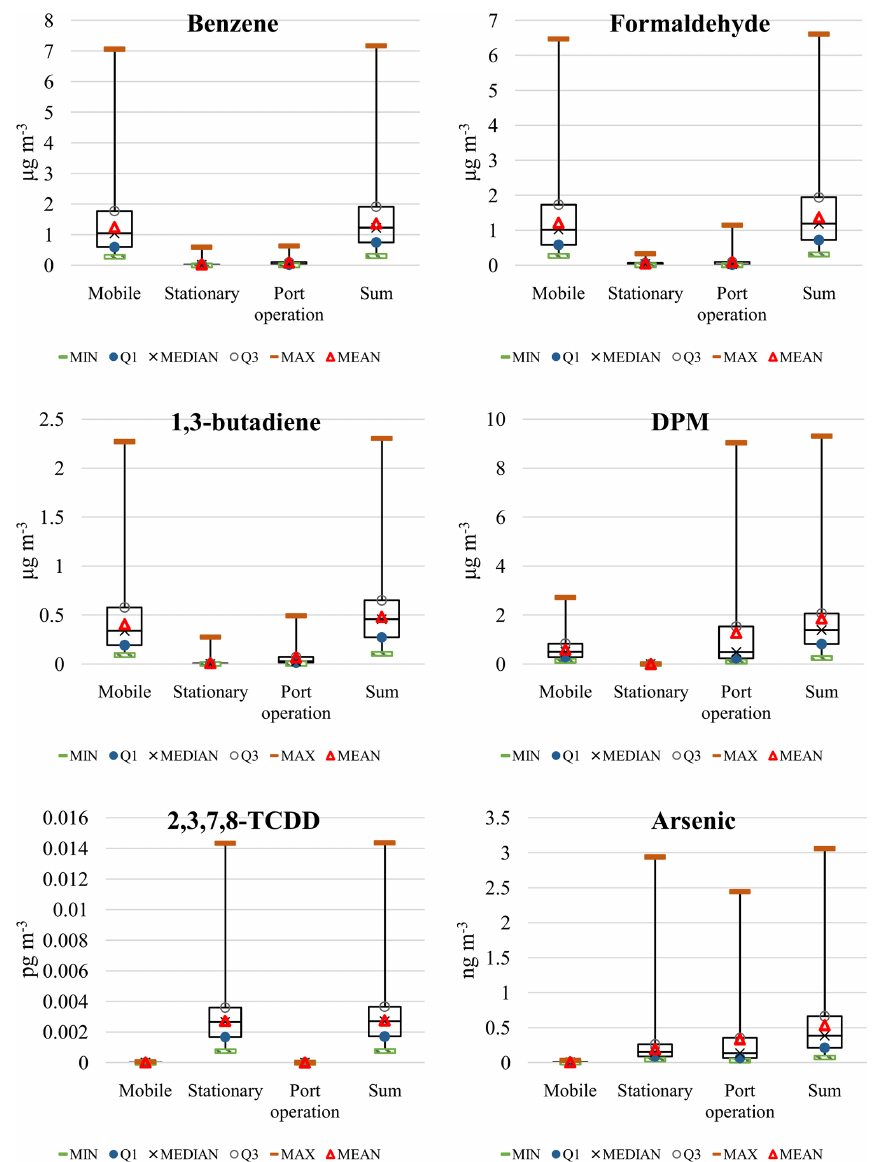
Figure 2. Incremental concentrations due to various emission